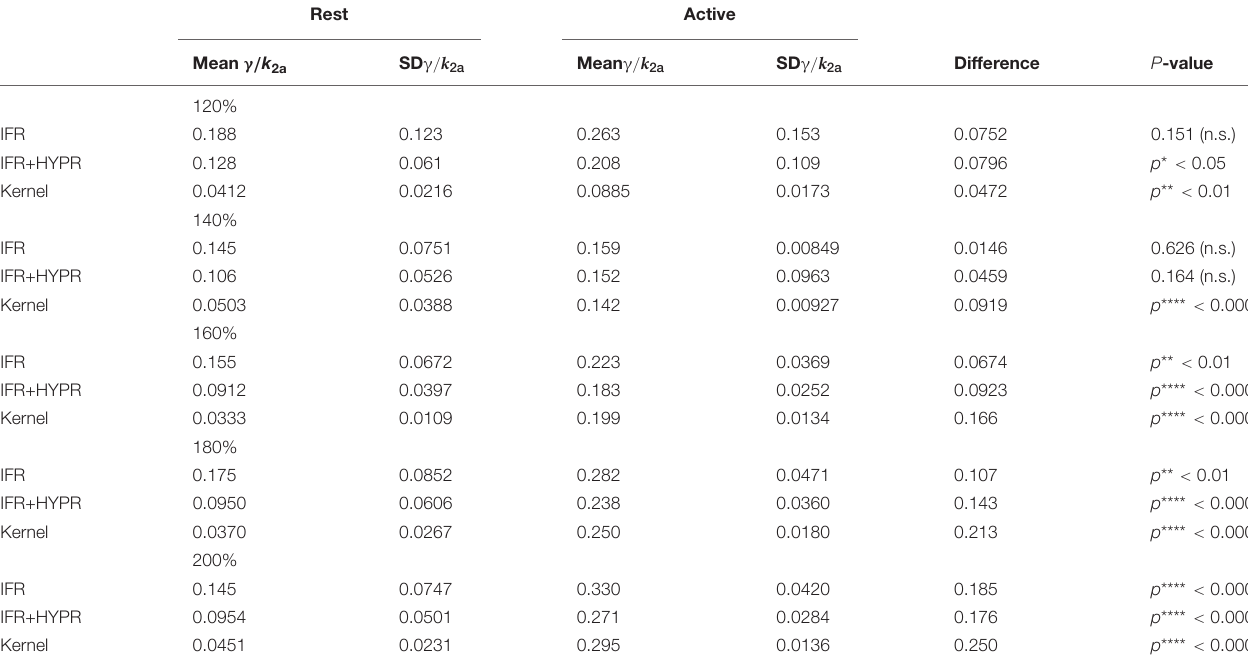
TABLE 3 | Mean and standard deviation of the relative magnitude of γ in the active and rest regions, as well as their difference and significance, for peak levels of activation of 120, 140, 160, 180, and 200% the baseline level.